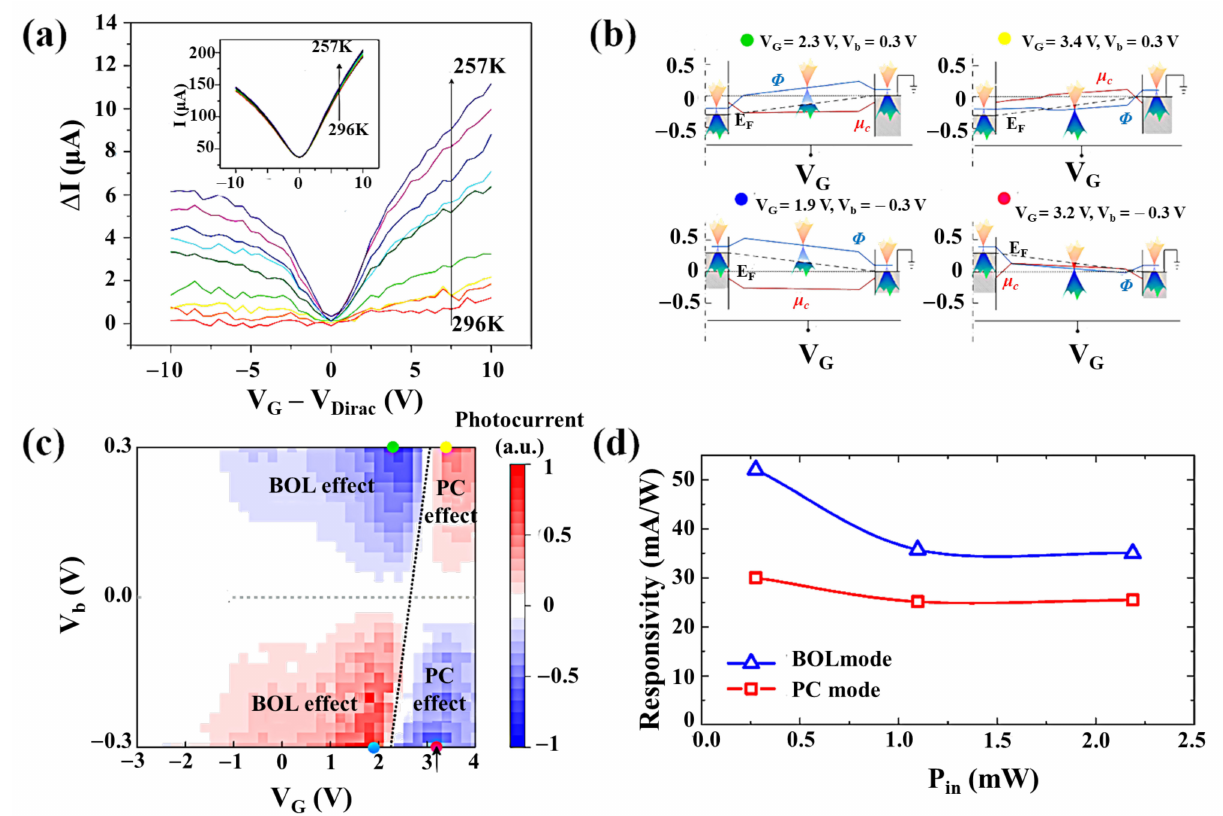
Figure 5. Photobolometric Effect. ( a ) Temperature-dependent change in current from its room temperature value as a function of gate voltage. Inset: gate voltage characteristic as a function of temperature when cooling down from room temperature. ( b ) Calculated energy band diagrams for the different cases. ( c ) Measured photocurrent map as the V GS and the source–drain voltage (V DS ) vary. ( d ) Measured responsivities with different input optical powers Pin. ( a ) Reproduced with permission from [69]. Copyright Nature Publishing Group, 2012. ( b – d ) reproduced with permission from [73]. Copyright Nature Publishing Group,